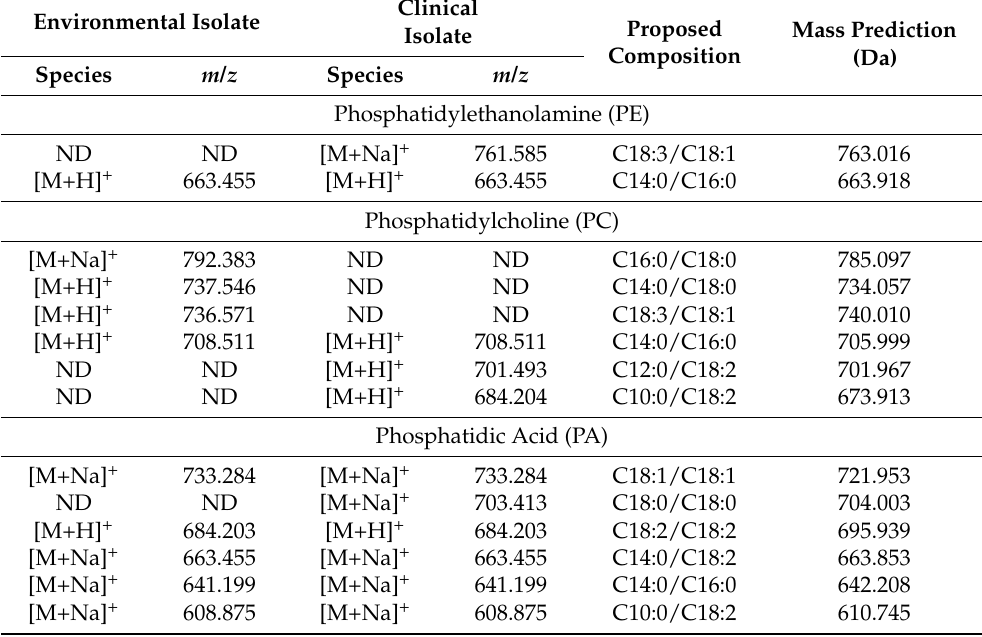
Table 1. Composition of major phospholipids tentatively identified by ESI (positive-ion charge)-MS total ion associated to the external surface of the cell wall of the mycelial phase of the environmental and clinical isolates of H. capsulatum (ND: Not